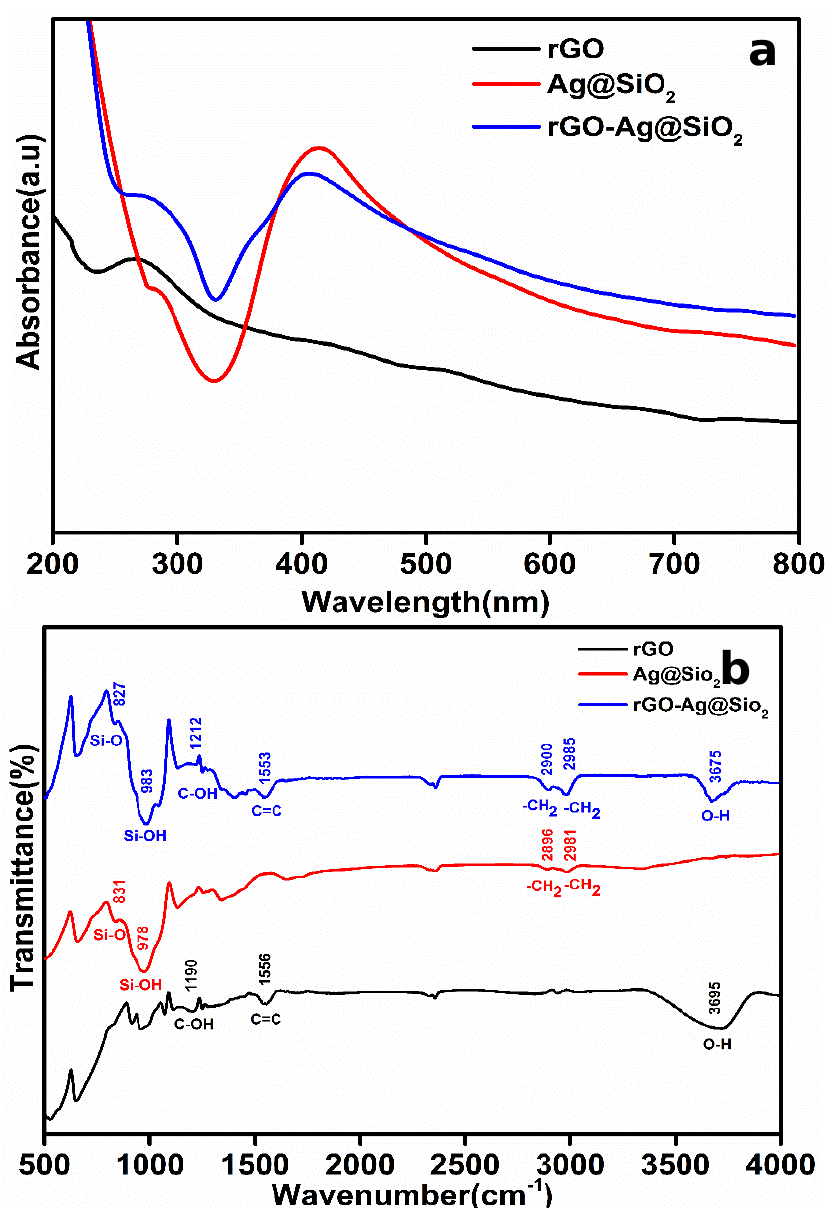
Figure 3. ( a ) The UV absorption spectra and ( b ) Fourier transform infrared (FTIR) spectra of rGO,